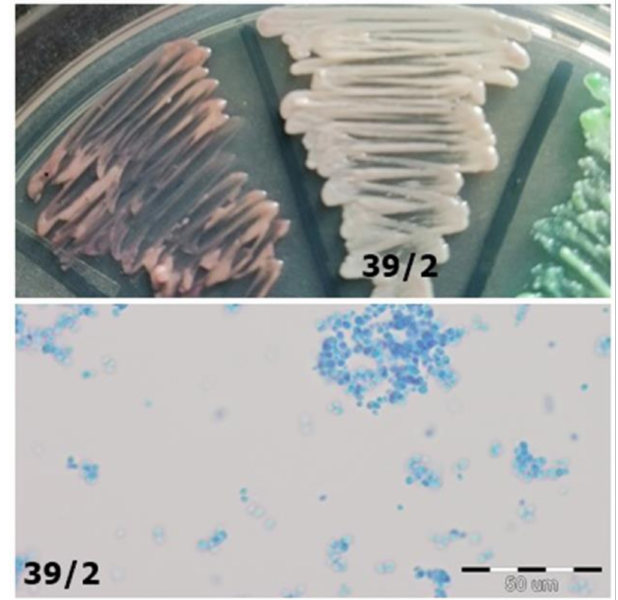
Figure 5. Strain 39/2-morphology on CHROMagar Candida and 40 × zoom (Lactophenol Cotton Blue; private collection).